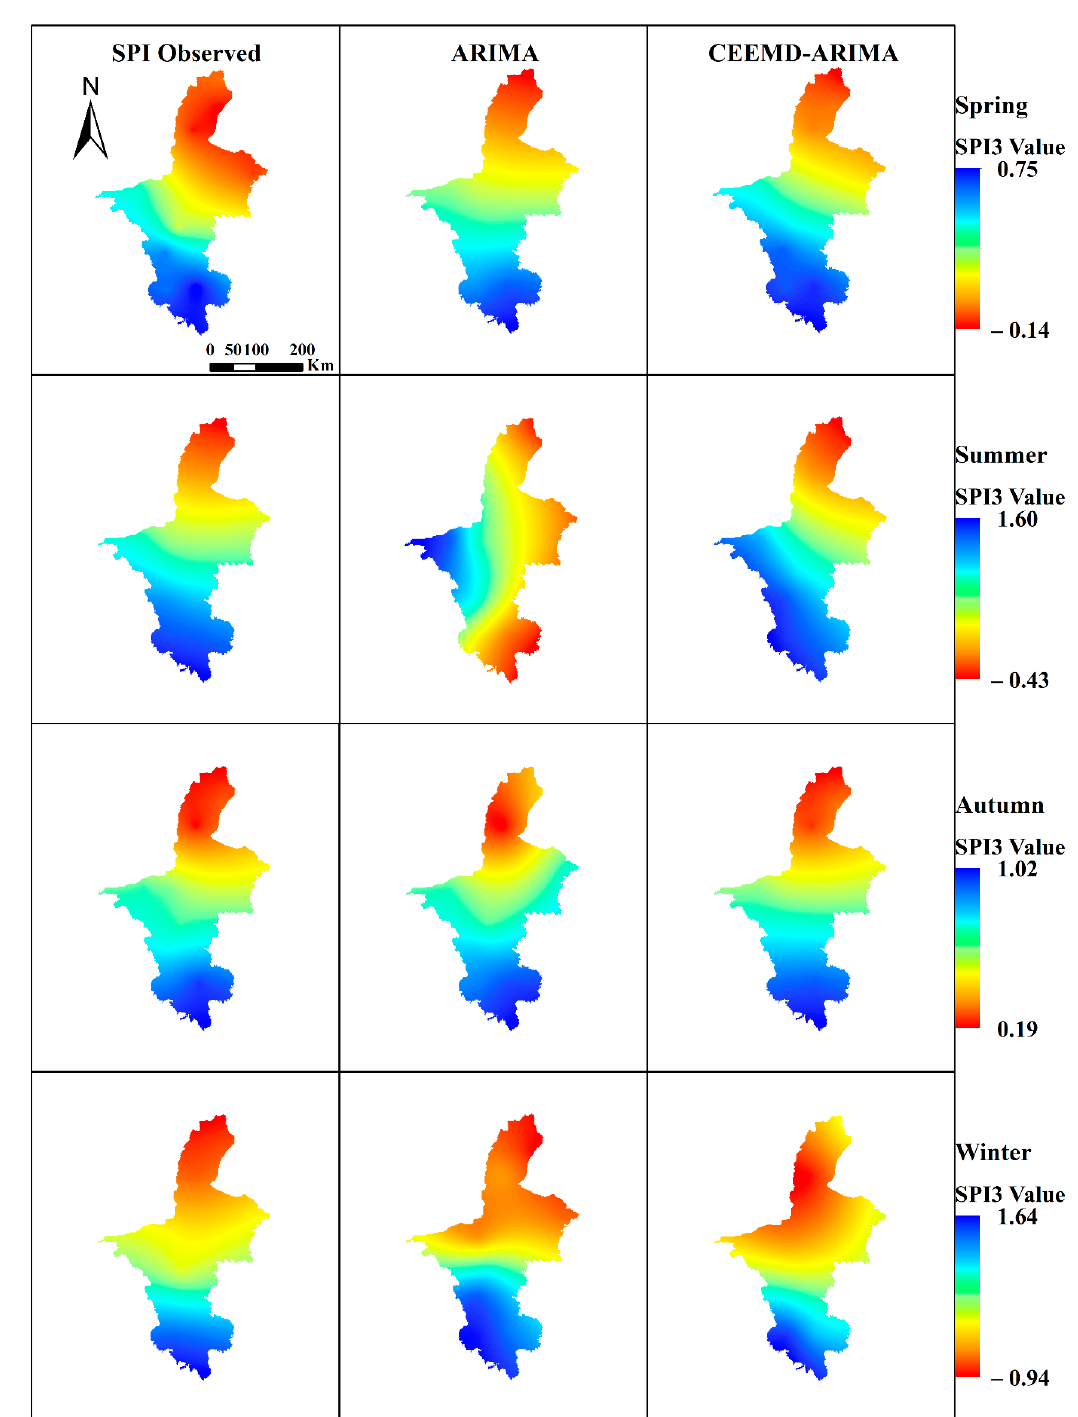
Figure 8. Kriging interpolation results of the actual calculated values and the predicted values of the ARIMA model and the CEEMD–ARIMA model.